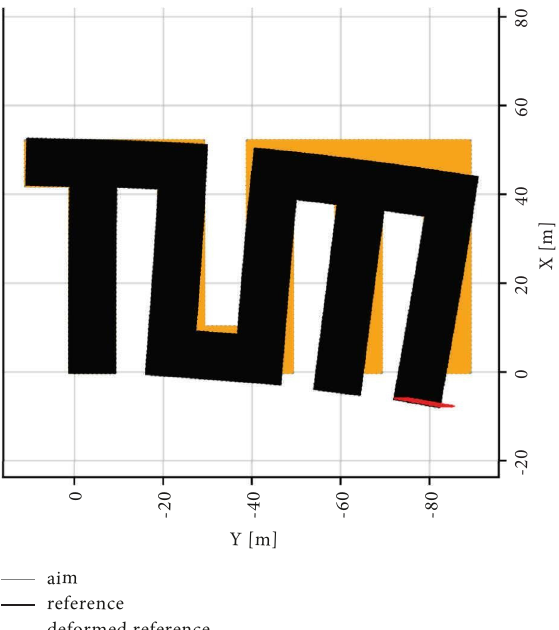
Figure 24: Unknown reference confguration and desired aim confguration for the nonlinear truss TUM logo. Boundary conditions are given in Figure